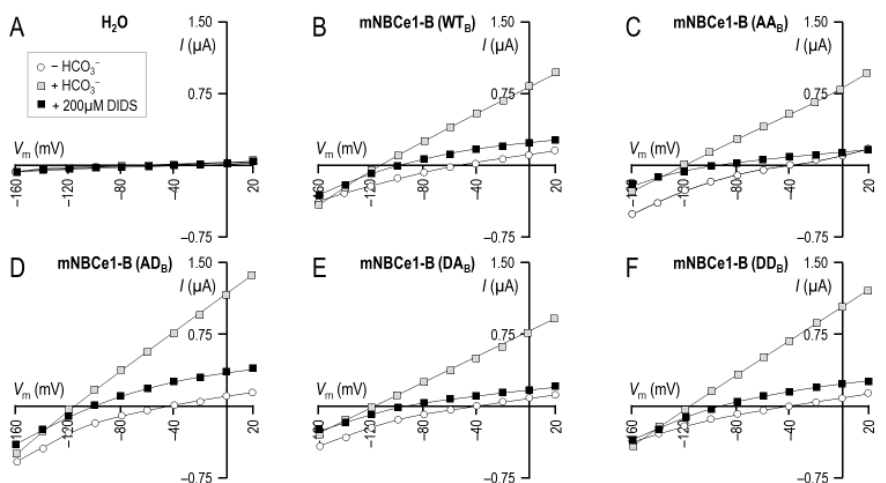
Figure 7. I–V relationships for oocyte expressing (de)phosphomimetic NBCe1-B clones. Each panel shows data gathered from a single representative oocyte injected with either ( A ) H 2 O, ( B ) cRNA- encoded wild-type NBCe1-B-EGFP, or ( C – F ) one of five cRNA-encoded (de)phosphomimetic mutants. Open circles are I–V data gathered from oocytes during perfusion with our CO 2 /HCO 3 − -free solution, gray squares are I–V data gathered during perfusion with our CO 2 /HCO 3 − -containing solution, and black squares are I–V data gathered during perfusion with our CO 2 /HCO 3 − -containing solution plus 200 µ M DIDS.